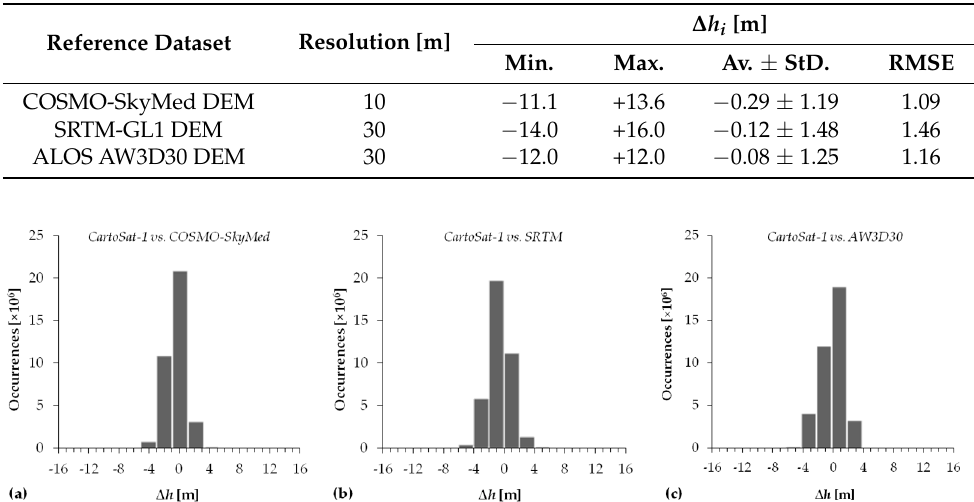
Table 1. Comparison of the CartoSat-1 DSM with the three reference DEM datasets. Notation: Δ h i , elevation difference; Min., minimum; Max. maximum; Av., average; StD., standard deviation; RMSE, root mean square error.